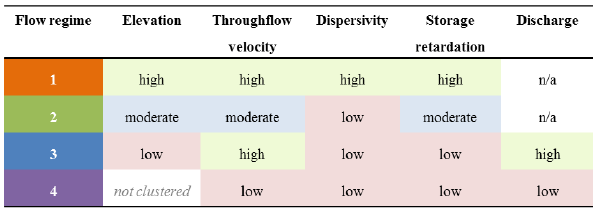
Figure 8. Characteristics of meltwater flow regimes 1 to 4, where high, moderate and low are relative to measured values. Variables for which values did not fall within the same classification are indi- cated as “not